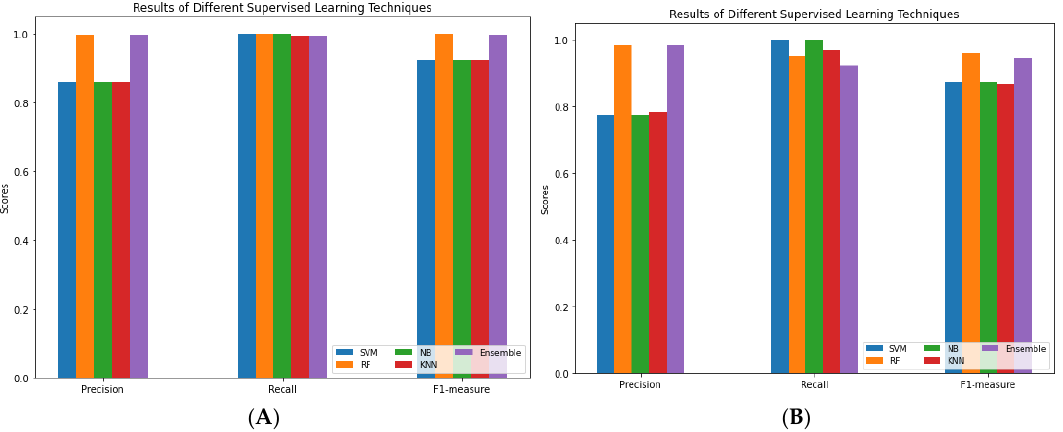
Figure 5. The results of other classifiers compared to RF ( A ) for group 1 hashtags and ( B ) for group 2 hashtags.